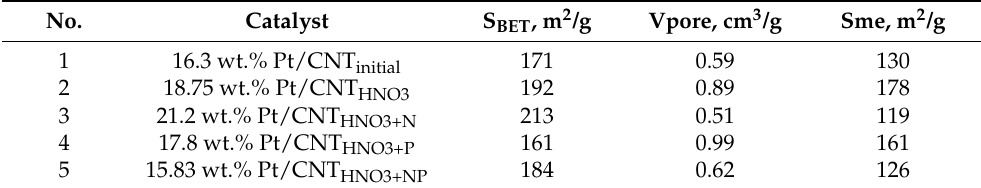
Table 1. Structural characteristics of the synthesized monoplatinum catalysts.